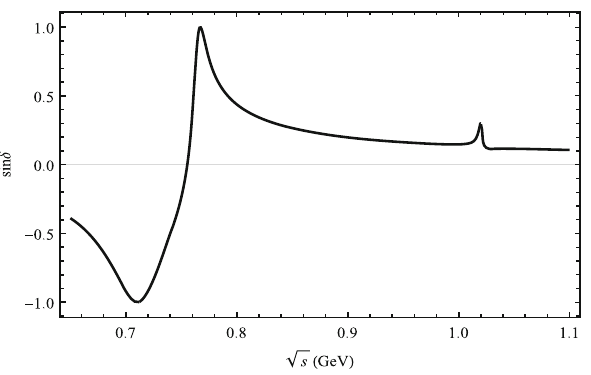
Fig. 5 Plot of A CP as a function of parameter values of CKM matrix elements for the decay channel of ¯ B 0